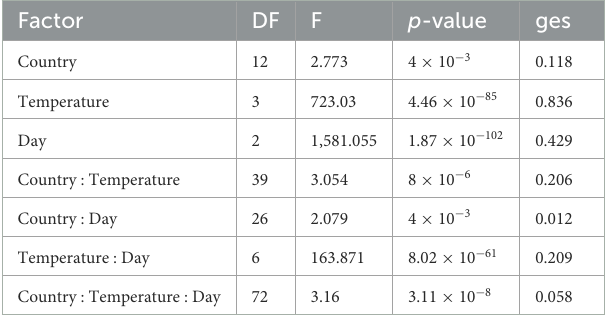
TABLE 3 Mixed ANOVA on the contributions of country of origin, temperature, and day post incubation and their interactions on the growth of A. fumigatus